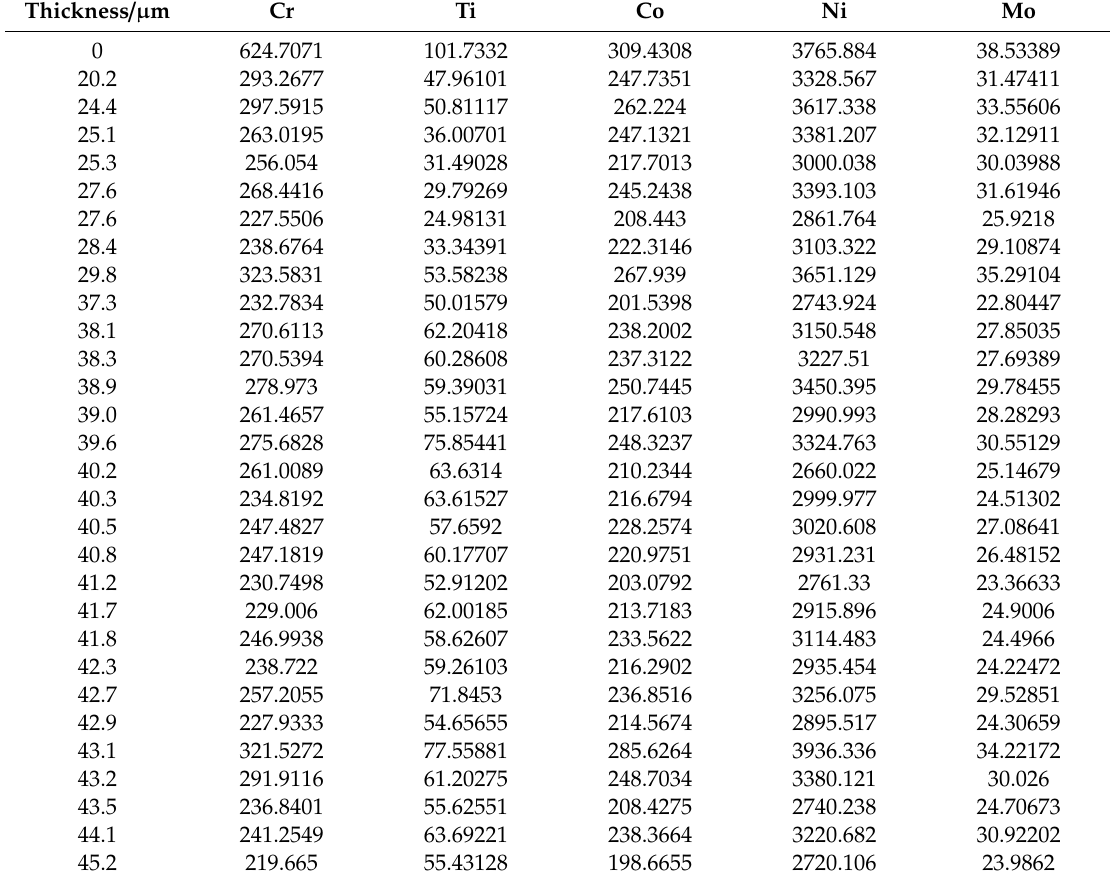
Table 3. Fluorescence intensity of main elements in samples with di ff erent